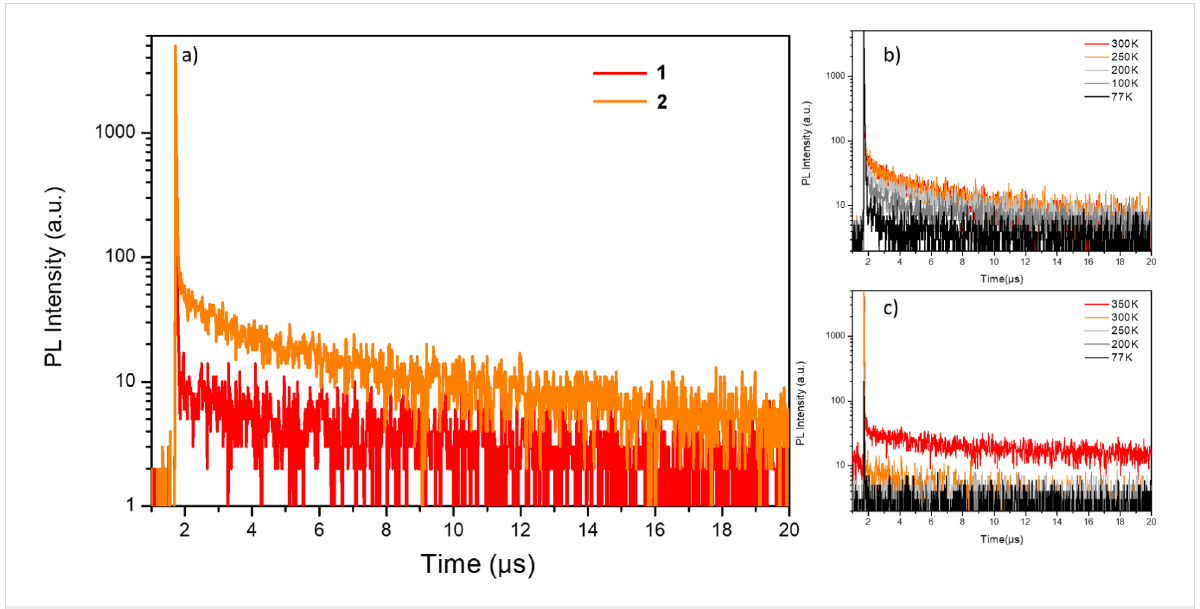
Figure 4: (a) Time-resolved transient photoluminescence decay spectra of the doped films (8 wt % in CBP) measured in N 2 at 300 K; time-resolved transient photoluminescence decay spectra of (b) 2 :CBP and (c) 1 :CBP measured in N 2 at different temperatures.